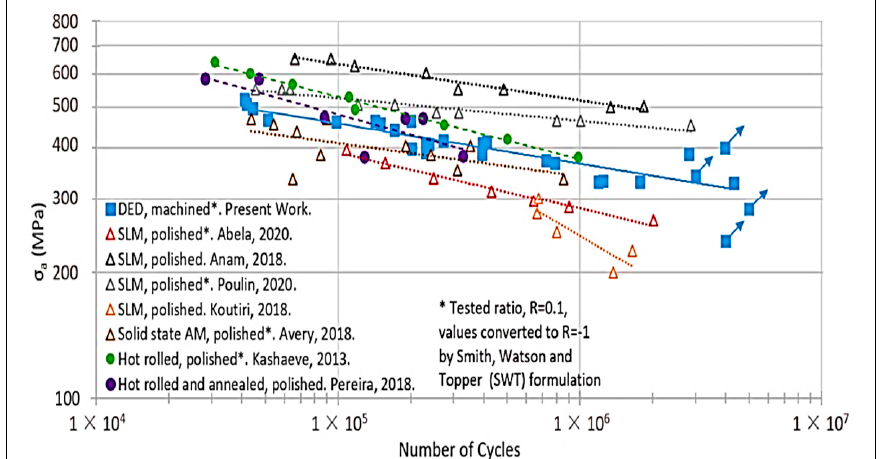
Figure 14. Literature comparison, S-N, R = − 1(adapted from Ref. [50] 2022, MDPI). Thermal–Mechanical Fatigue Resistance of DLD IN625 rials are subjected to simultaneous cyclic loads combined with high cyclic